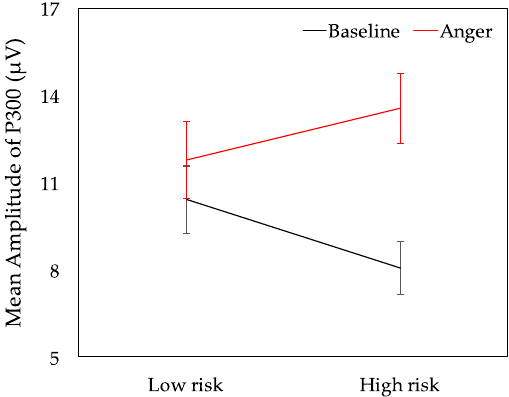
Figure 6. Mean amplitude of P300 for different risk choices under the baseline ( black line ) and anger ( red line ) states. Error bars indicate the standard error of the mean.